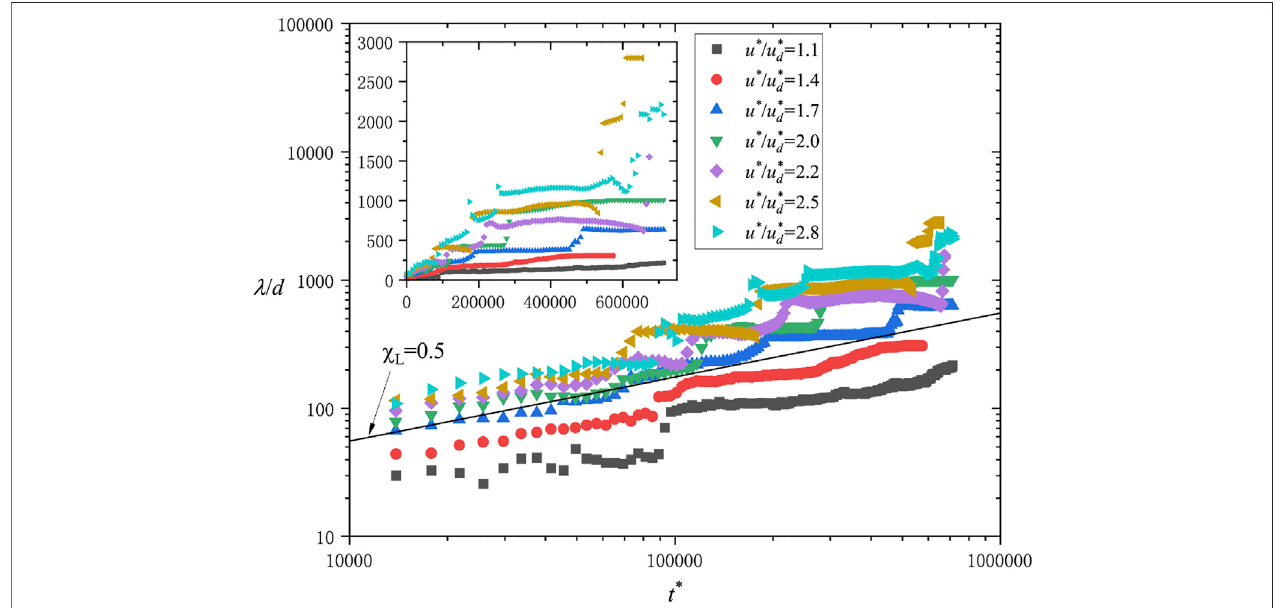
FIGURE 8 | Development of ripple wavelength with time. The inset demonstrates the same result in the linear coordinate system. The black solid line illustrates the χ (cid:1) 0 . 5 slope. L